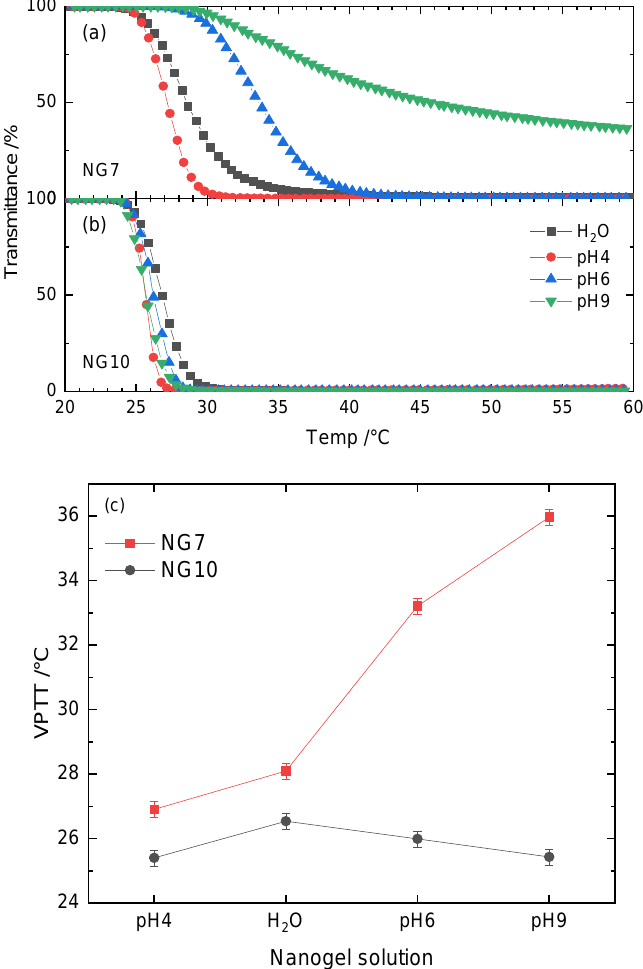
Figure 5. VPTT profiles of ( a ) NG7 and ( b ) NG10 in TAB buffer as a function of pH. Their corresponding VPTT values are summarized in ( c ).